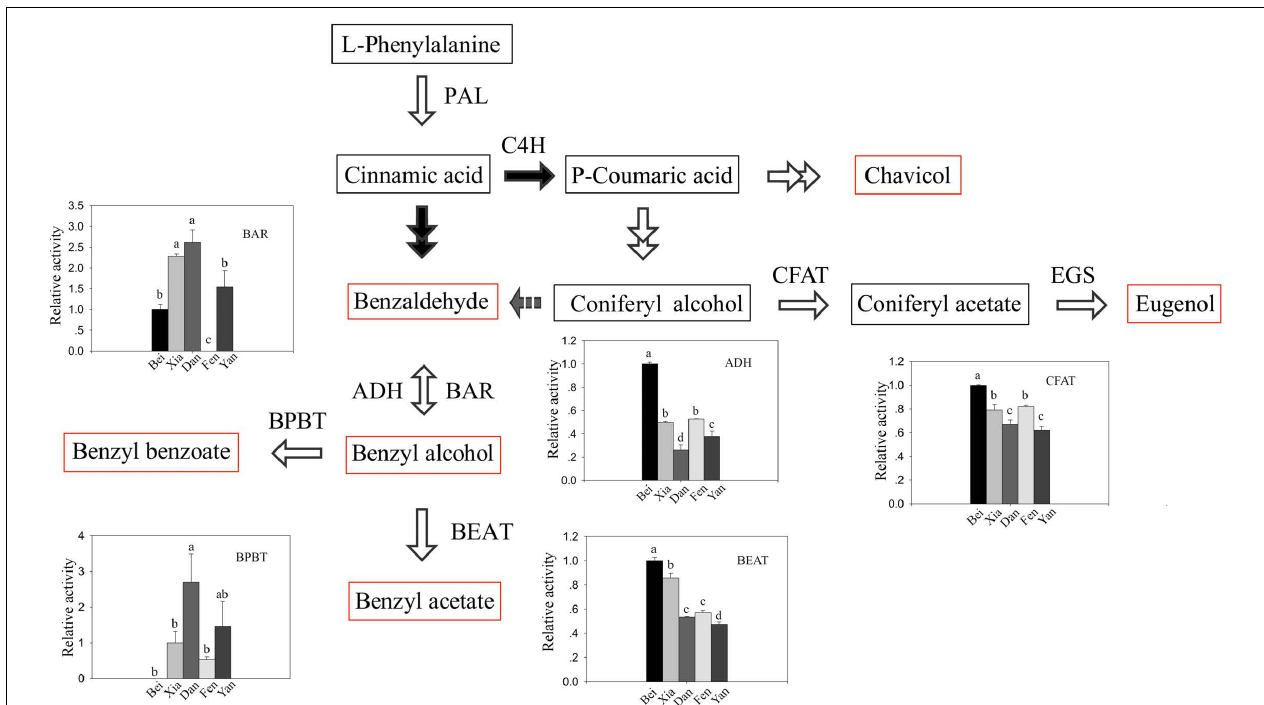
FIGURE 3 | The activity of key enzymes in the floral scent biosynthetic pathway. In the floral scent biosynthetic pathway, the red rectangles indicate the metabolites that were detected in intracellular pools, and the gray arrow indicates a proposed step that has not previously been described. The black-and-white graphs show the key enzyme activity levels in the different varieties. The data are presented as the mean values of three biological replicates ± SDs. Different letters indicate significant differences at the P = 0.05